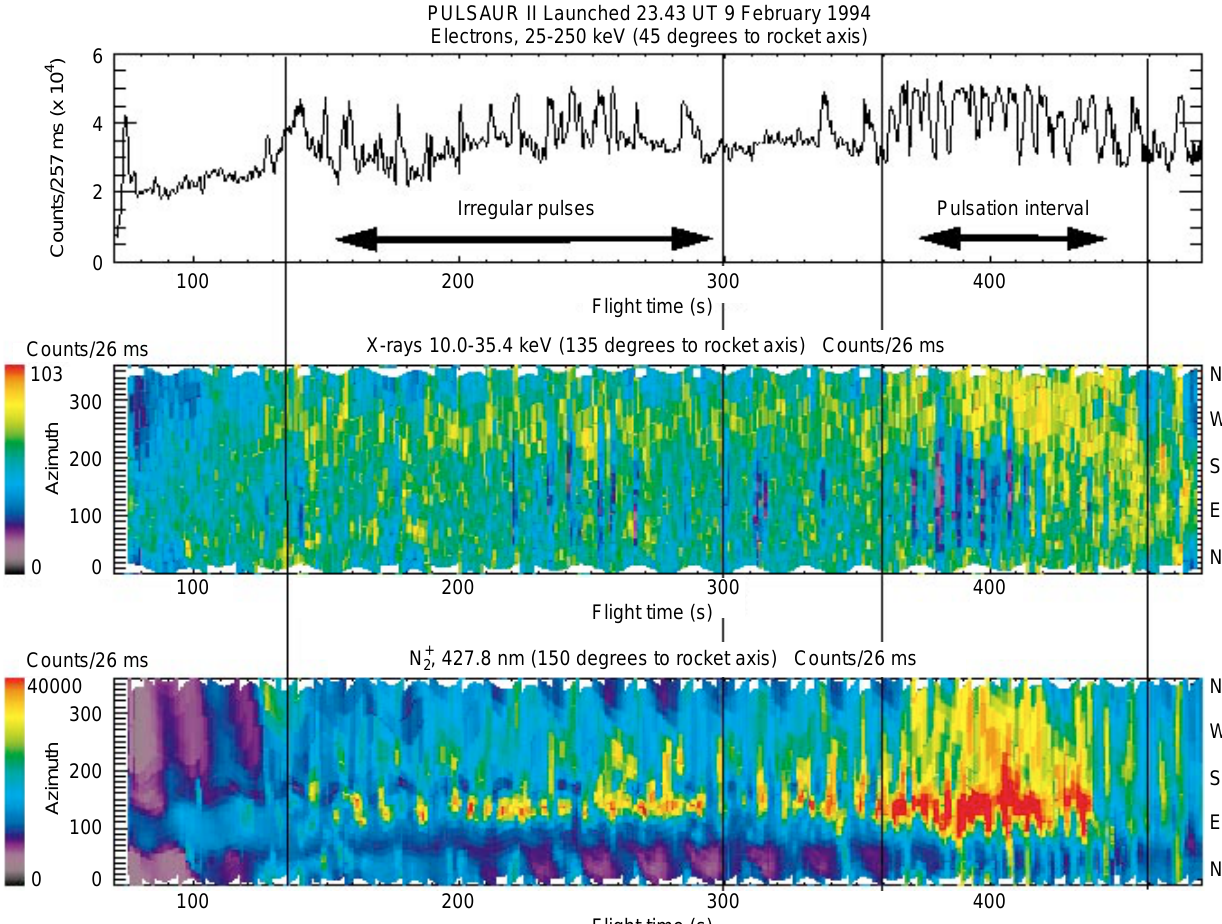
Fig. 2. Electrons (counts/257 ms): 25 < E e < 250keV, X-rays (counts/26 ms): 10 : 0 < E x < 35 : 4keV and N (cid:135) the whole